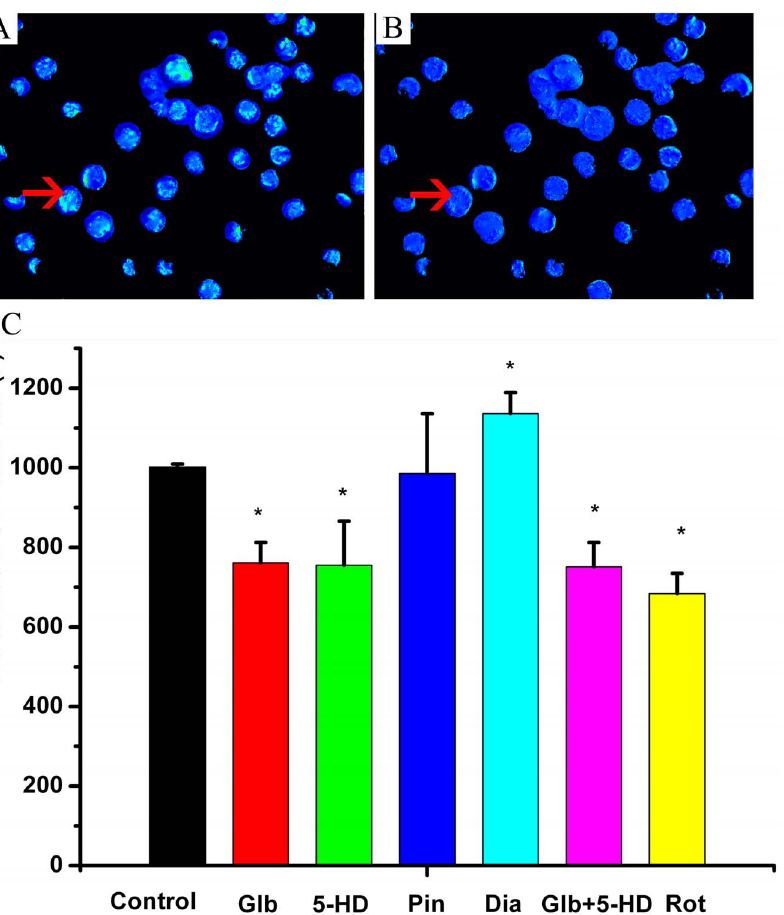
Figure 6. Effect of glibenclamide on mitochondrial activity. A, representative mitochondrial activity imaging in the control solution, the arrow showed the intensity of rhodamine-123 (Rh-123). B, representative mitochondrial imaging with glibenclamide (100 m M). C, Statistics of the intensity of Rh-123 using different agents. * P , 0.05, compared with the control.